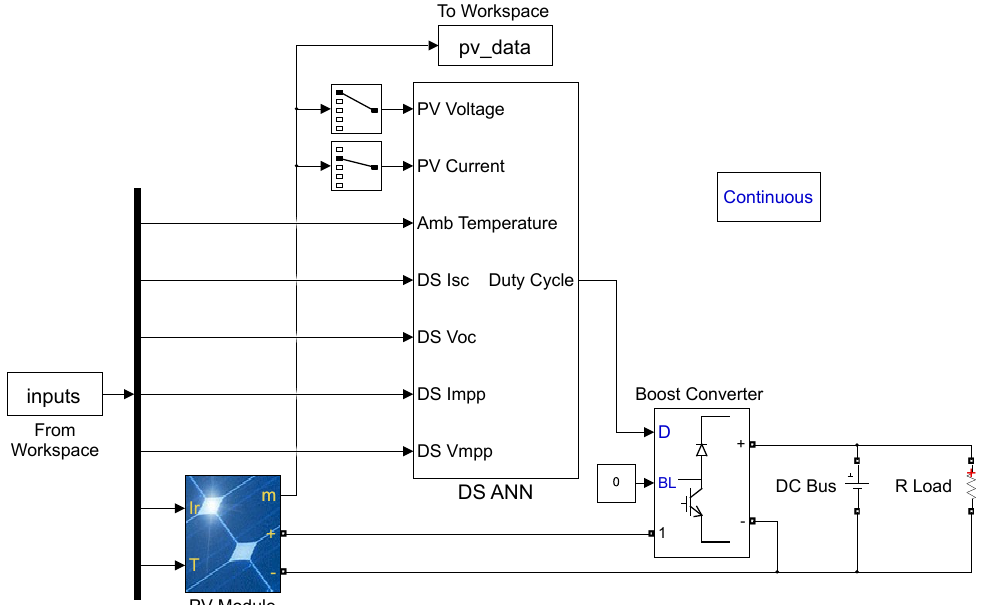
Figure 6. Simulink model for testing the proposed DS-ANN MPPT technique.